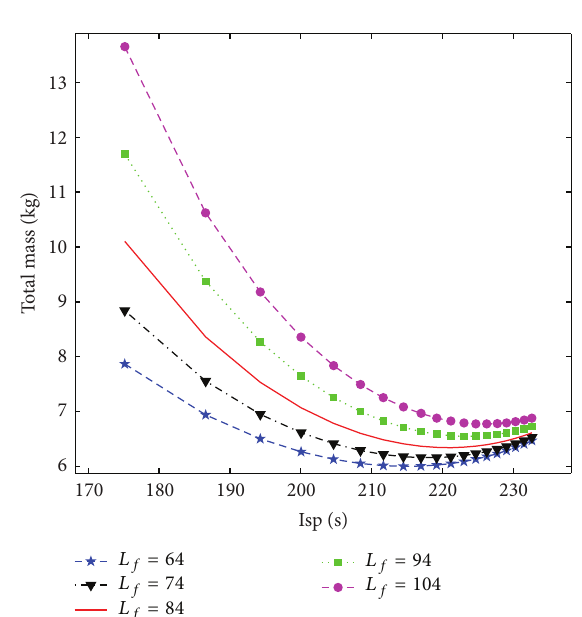
algorithm for monopropellant propulsion system based on AAO